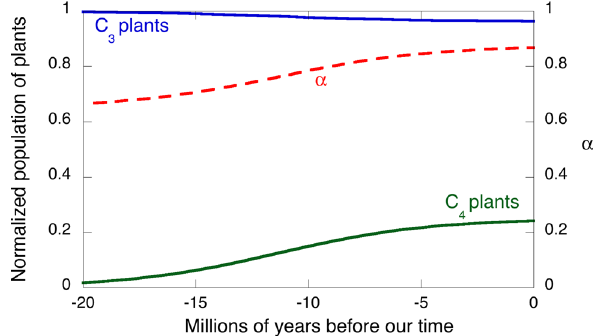
Figure 11. Left axis: changes in the relative populations of C3 and C4 plants, where the logistic equation was employed to express the explosive spread of C4 plants ca. 10 Myr ago at some cost of the C3 plants population. Right axis: value of α given the contributions of C3 and C4 plants weighted by their relative